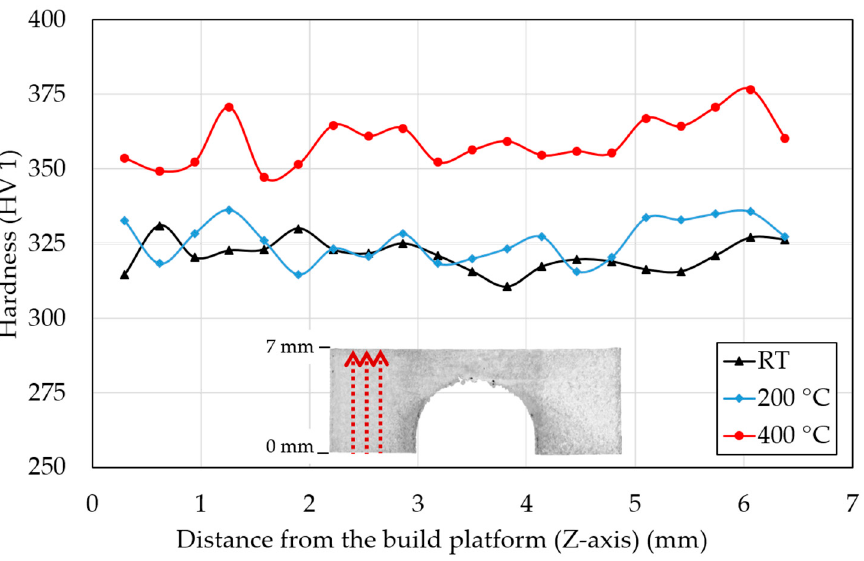
Figure 9. IN939 hardness of the BCM specimens produced using RT and base plate preheating at 200 °C and 400 °C.